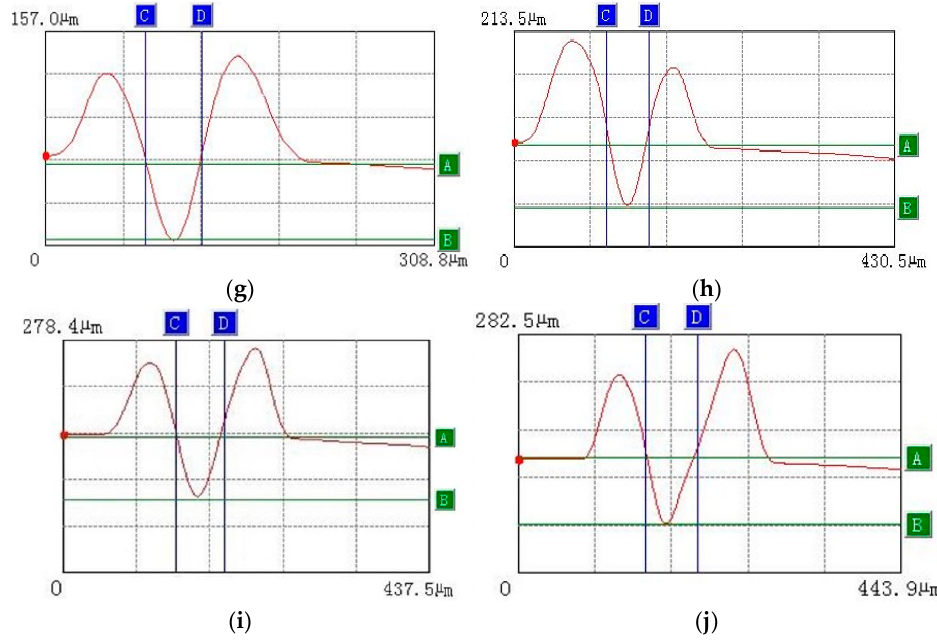
Figure 4. Numerical curve of light-focusing microscope: ( a ) 5 W; ( b ) 10 W; ( c ) 15 W; ( d ) 20 W; ( e ) 25 W; ( f ) 30 W; ( g ) 35 W; ( h ) 40 W; ( i ) 45 W; ( j ) 50 W. According to Figure 4, the width and depth of the ablation zone on the surface of the SiC p /Mg composite after ablation can be obtained. When the power gradually increases, the numerical changes in the ablation width and depth can be observed, as shown in Figure 5.